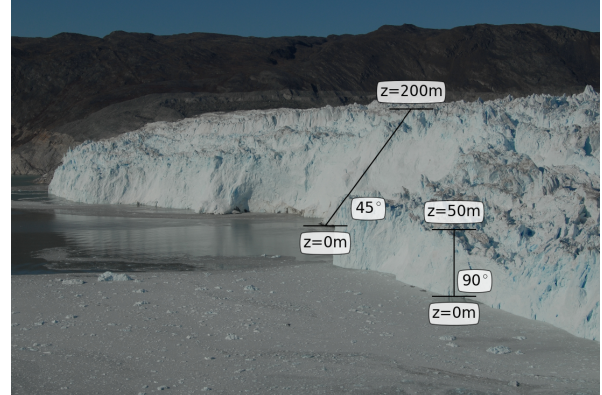
Figure 1. Calving front of Eqip Sermia glacier in July 2016. The boxes in the picture describe the geometrical properties of the two distinct parts of the calving